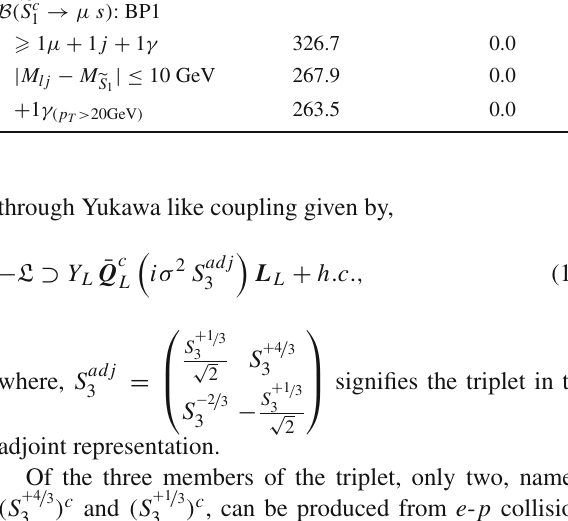
√ s = 318 . 12 GeV with L int = / 3 ) c Signal ( (cid:8) S + 4 1